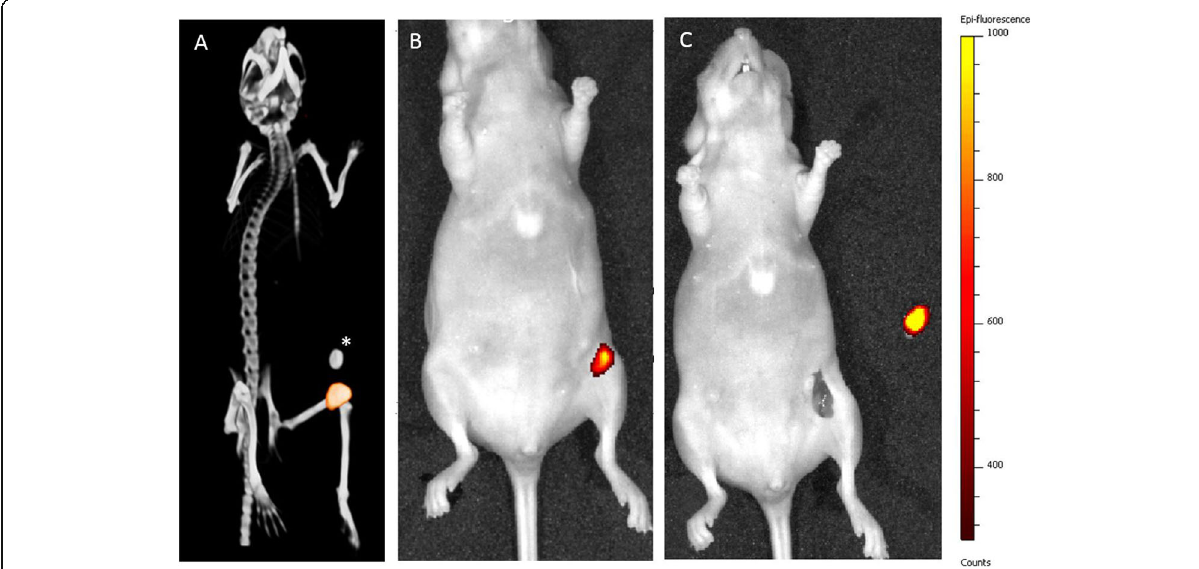
Fig. 4 As an example a SPECT/CT image (supine position) of a mouse bearing a BT474 tumor ( a ), 48 h after injection of 30 μ g [ 111 In]In-DTPA- trastuzumab-IRDye800CW, showing high uptake in the tumor. Fluorescence images before and after resection of the tumor ( b , c ), with a selected epi-fluorescence scale of 300 – 1000 counts. *Implanted estradiol